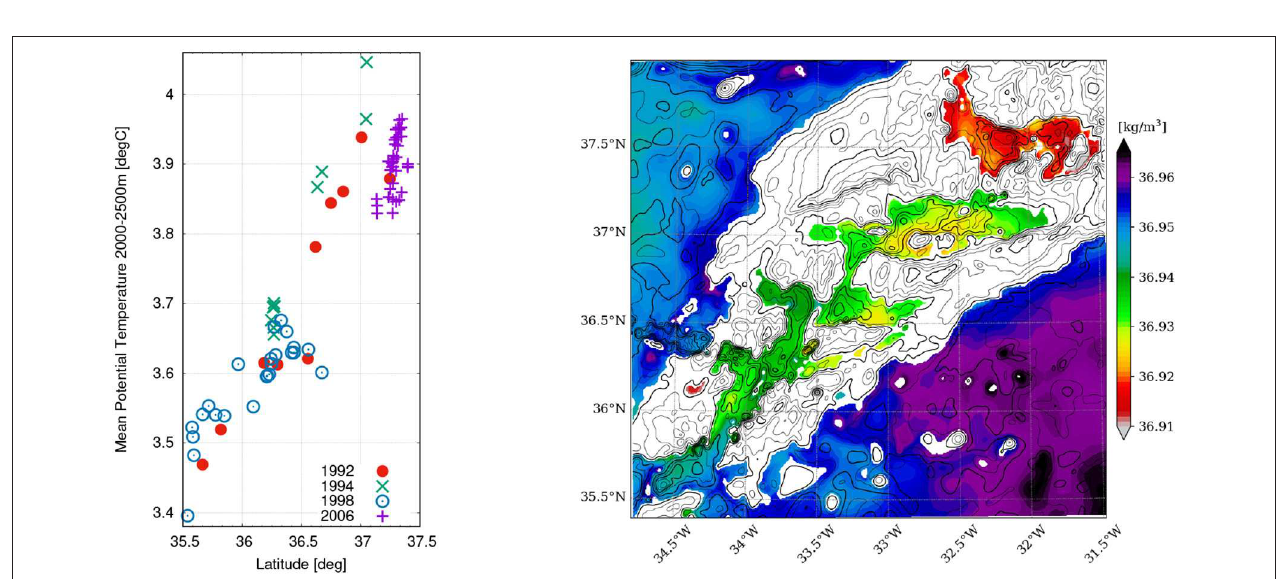
FIGURE 4 | LADCP velocities at 1,900 m observed during two surveys of the Lucky-Strike segment center in 2006 and 2007 (St. Laurent and Thurnherr, 2007; Thurnherr et al., 2008).